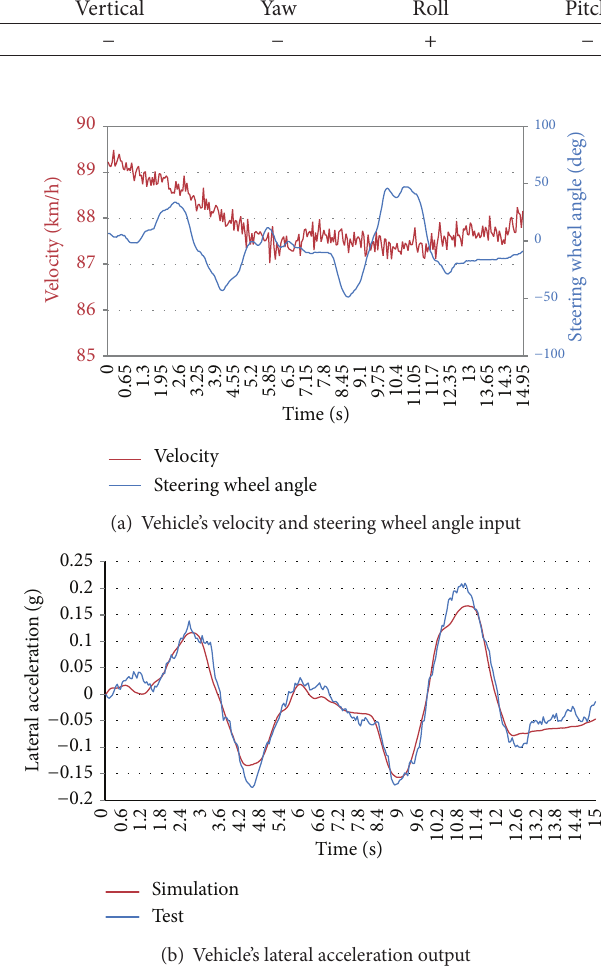
Figure 4: Comparing simulation with vehicle